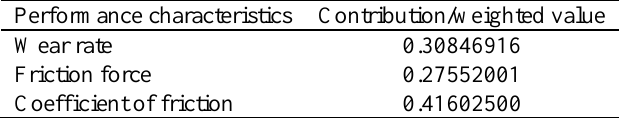
Table 8. The most variance contribution of each individual performance characteristic for the principal component.